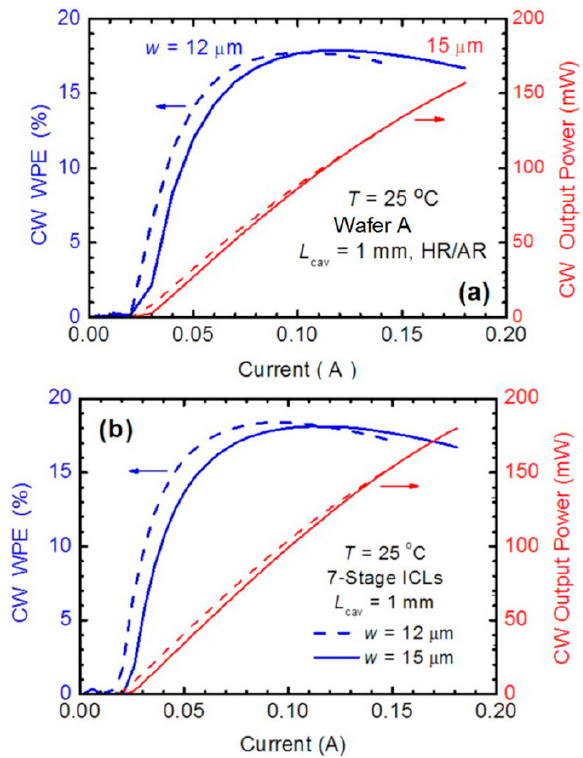
Figure 11. L-I characteristics (red) and wallplug e ffi ciencies (blue) for narrow ridges with 1 mm cavity length and HR / AR facet coatings in cw mode at T = 25 ◦ C: ( a ) Two 10-stage ICLs with 12 µ m (dashed) and 15 µ m (solid) ridge widths; ( b ) two 7-stage ICLs with 12 µ m (dashed) and 15 µ m (solid) ridge widths. All four lasers exhibit WPEs up to 18%, the highest ever reported for an ICL [109].